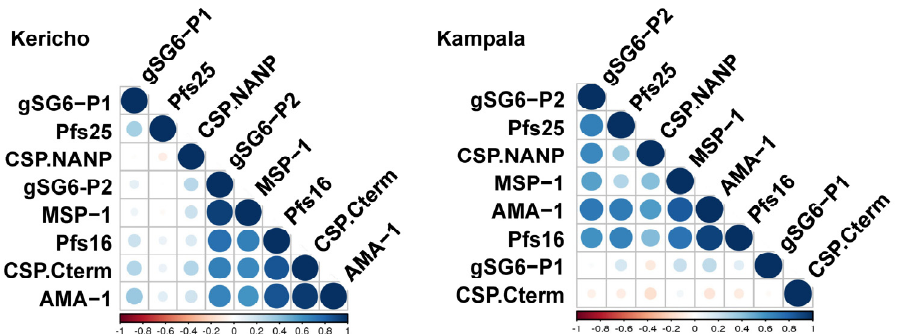
Figure 4. Correlation between antigen-specificities in the serological profile differ depending on malaria-endemicity. Correlation matrices depict the interactions between the different factors—the degree of correlation is indicated by color and color intensity (color bar indicates the legend for the statistical significance).